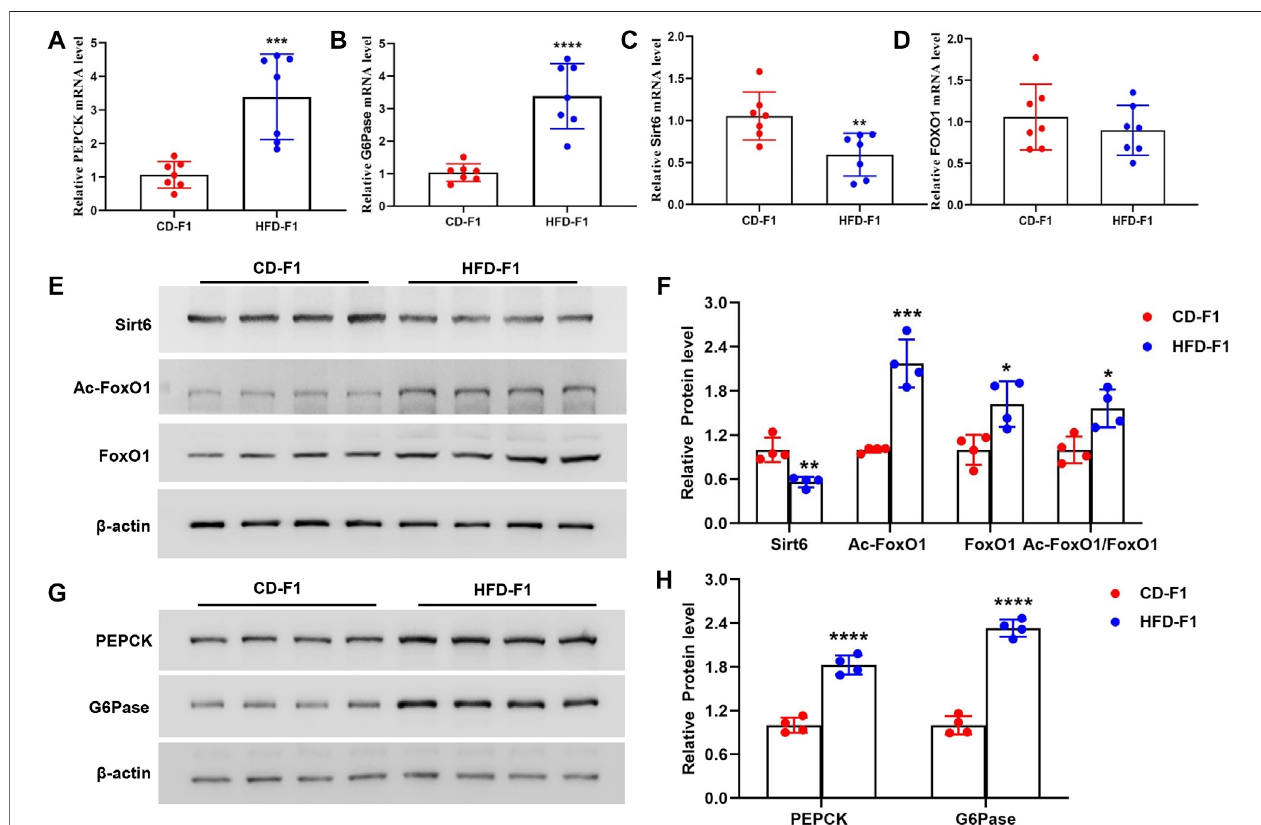
FIGURE 3 | Altered Sirt6-FoxO1 signaling associated with hepatic gluconeogenesis in HFD-F1 mice. (A – D) PEPCK (A) , G6Pase (B) , Sirt6 (C) and FoxO1 (D) mRNA level in liver tissue from HFD-F1 mice and CD-F1 mice was examined by Real-time PCR ( n = 7). (E , F) Sirt6, Ac-FoxO1, FoxO1 and Ac-FoxO1/FoxO1 protein expression in liver tissue from HFD-F1 mice and CD-F1 mice was detected by western blot analysis ( n = 4). (G , H) PEPCK and G6Pase protein expression in liver tissue from HFD-F1 mice and CD-F1 mice was detected by western blot analysis ( n = 4). * p < 0.05, ** p < 0.01, *** p < 0.001, **** p < 0.0001.